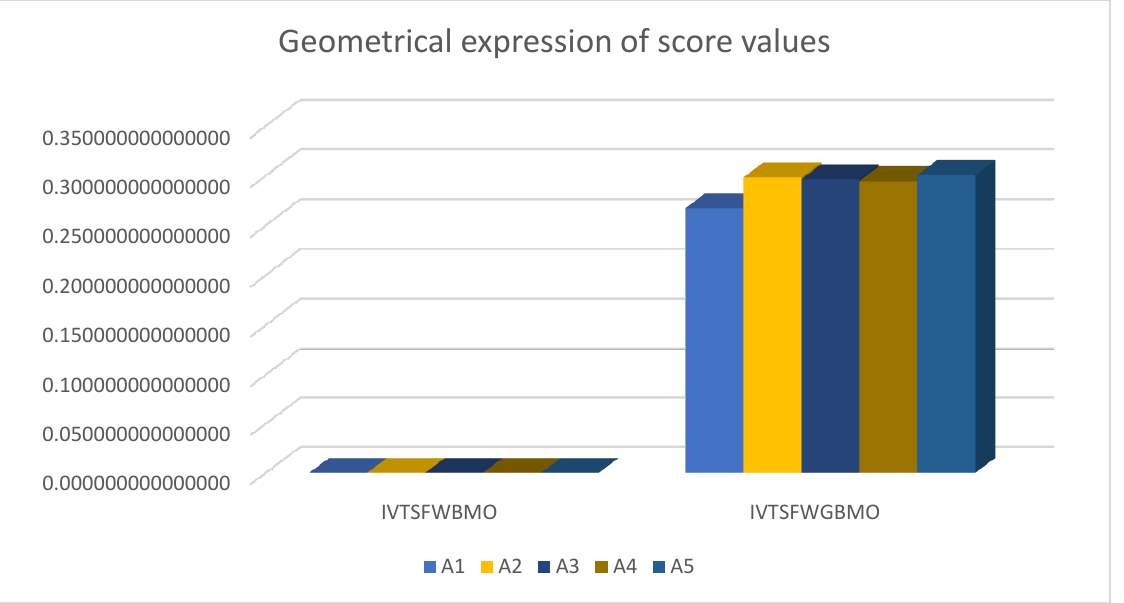
Figure 1. Illustration of the information in Table 6 .